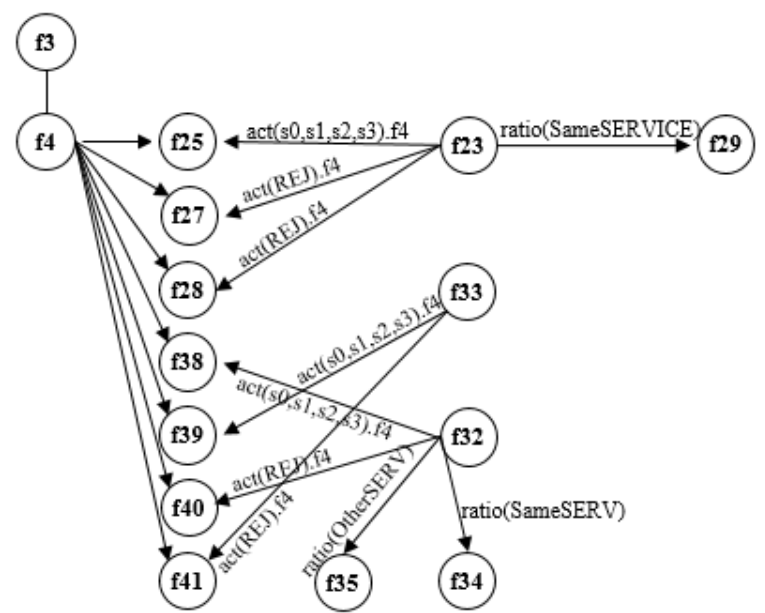
Figure 5. Correlation of each feature.